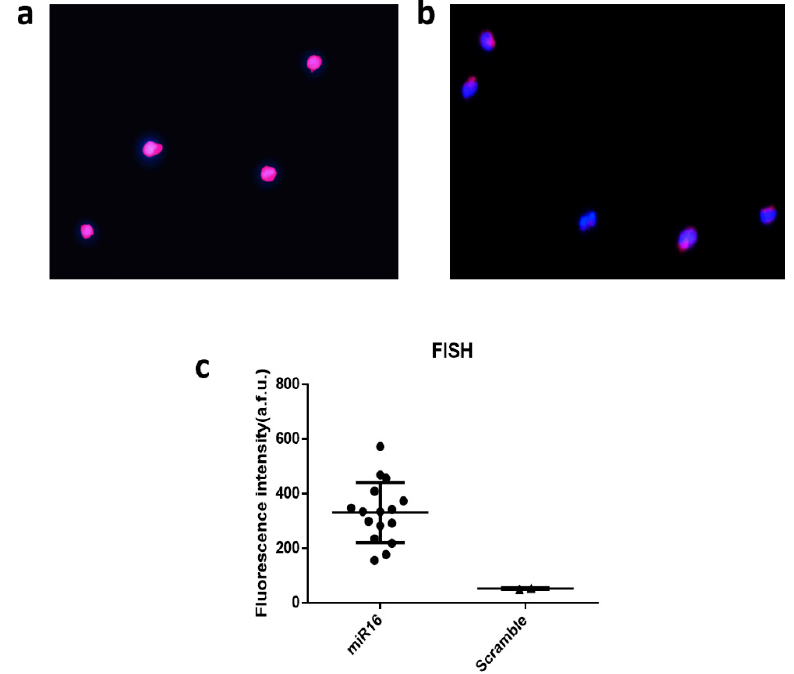
Figure 5. Single-cell fluorescent in situ hybridization (FISH) for single-cell data validation. ( a ) Fluorescence image showing miR-16 detection by fluorescence in situ hybridization (FISH). ( b ) Fluorescence image from negative control using the scrambled sequence; Blue color is for DAPI and pink is for APC to report the FISH signal; ( c ) Quantitative analysis of single-cell miR-16 expression by FISH as compared to scramble. Each dot is a single cell .